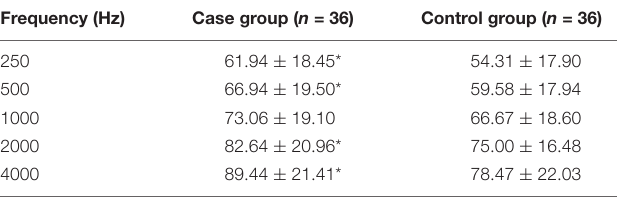
TABLE 2 | AC thresholds of case group and control group.